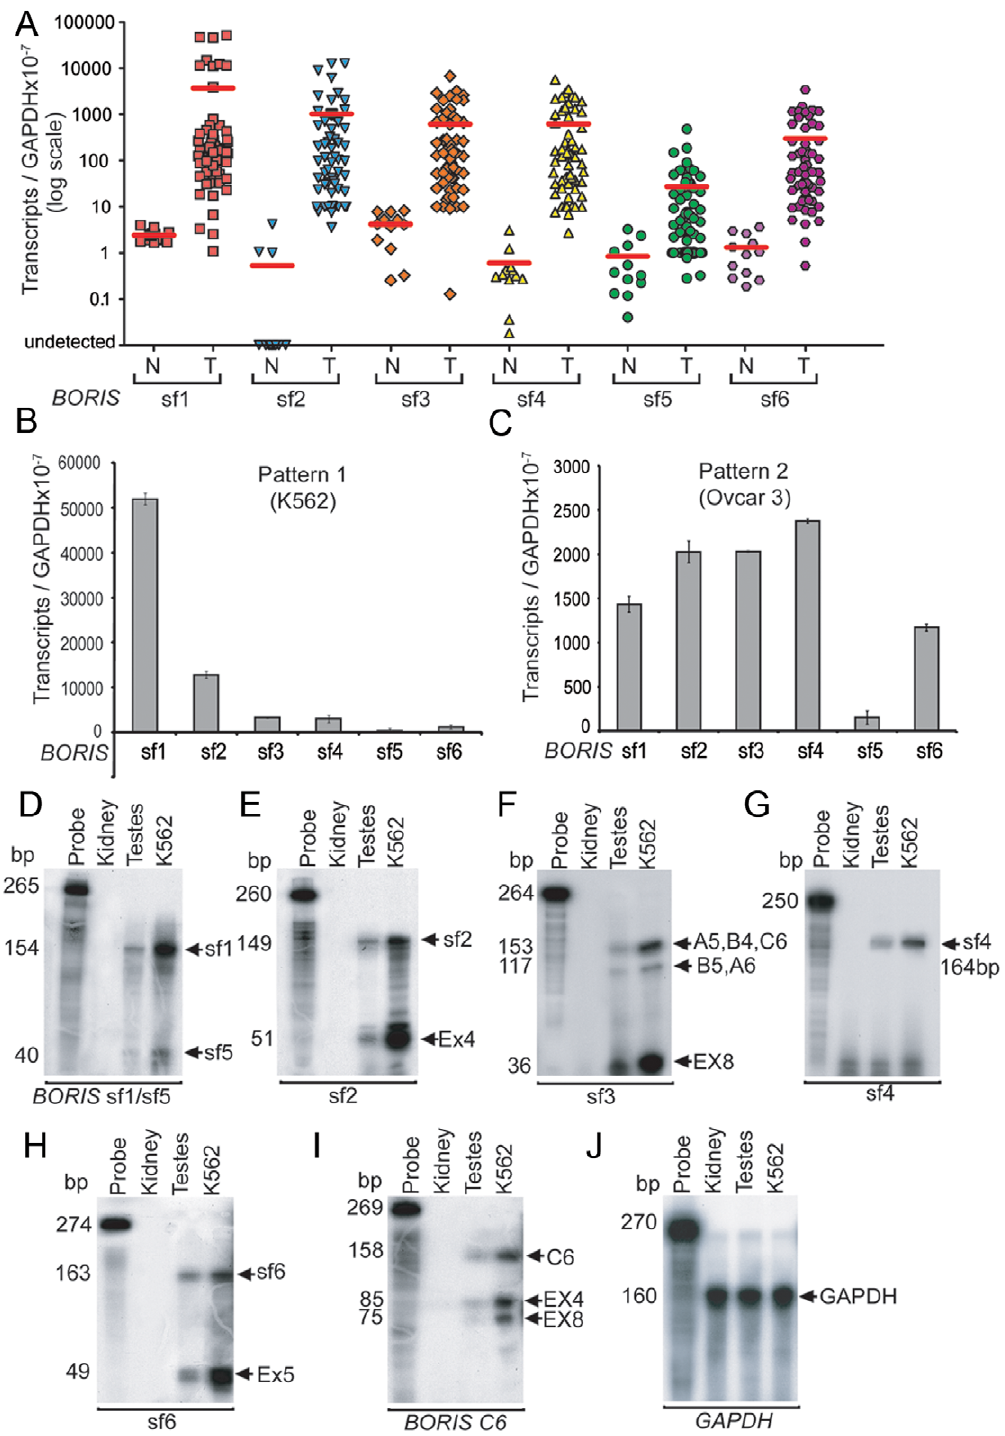
Figure 5. Expression of BORIS isoforms in cancer cell lines. ( A ) The BORIS subfamilies are significantly upregulated in cancer cells as compared to normal cells. For normal cells (N) – the expression of BORIS isoforms was analysed in 13 tissues and 4 primary cell lines. For tumor cells (T) - the NCI- 60 cancer cell lines were analyzed. 59 of the NCI-60 cancer cell lines, 13 normal tissues, and 4 normal primary cell lines were analyzed by the absolute quantification approach with normalization to GAPDH levels, and plotted using a logarithmic scale. Levels of BORIS isoform expression vary greatly (from 0 to 60000 transcripts per 50 ng of total RNA). Red lines indicate mean values for each BORIS subfamily. ( B ) The first pattern of BORIS isoform expression in NCI-60 cancer cells, as represented by the K562 cancer cell line. ( C ) The second pattern of BORIS isoforms expression in NCI-60 panel is exemplified by the Ovcar3 cancer cell line. ( D-J ) BORIS isoforms expression analyzed by RPA. Aliquots of total RNA obtained from kidney, testis and K562 cell line were hybridized with 32 P–labeled antisense RNA probes. The RNase protected fragments (arrowheads) were detected only in testis and K562, but not in kidney. The first lane on each gel is a control, an undigested probe incubated with yeast RNA. ( D ) RPA with riboprobe sf1/sf5 yields